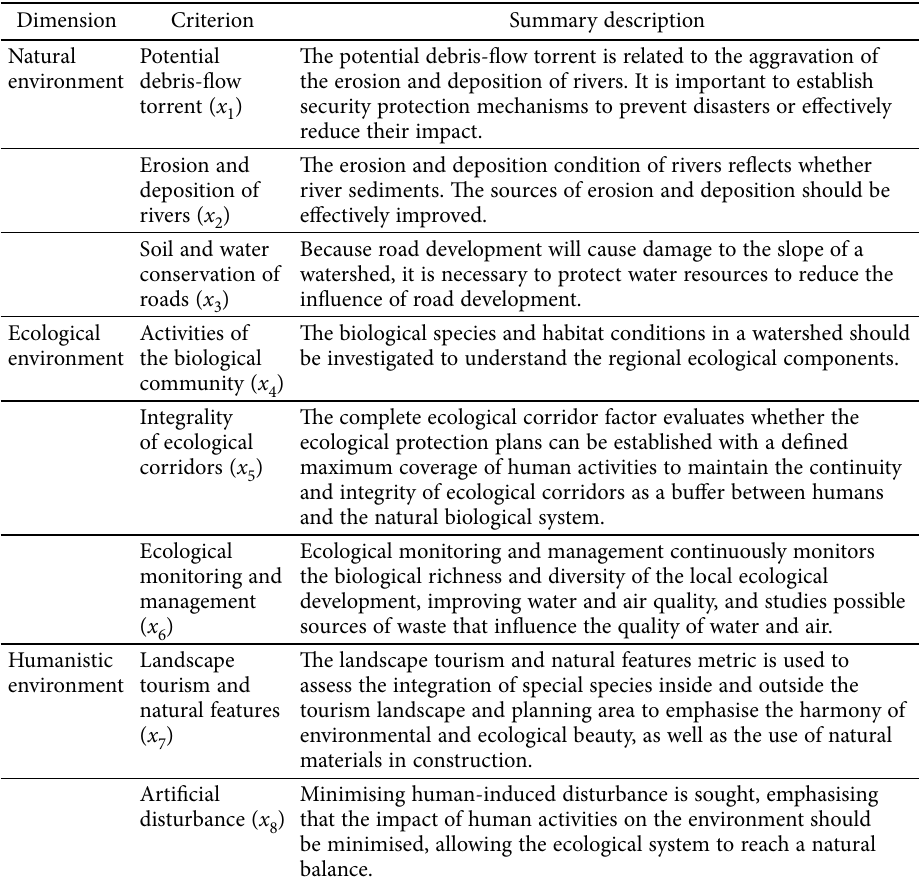
Table 2. Descriptions of the criteria for watershed site selection